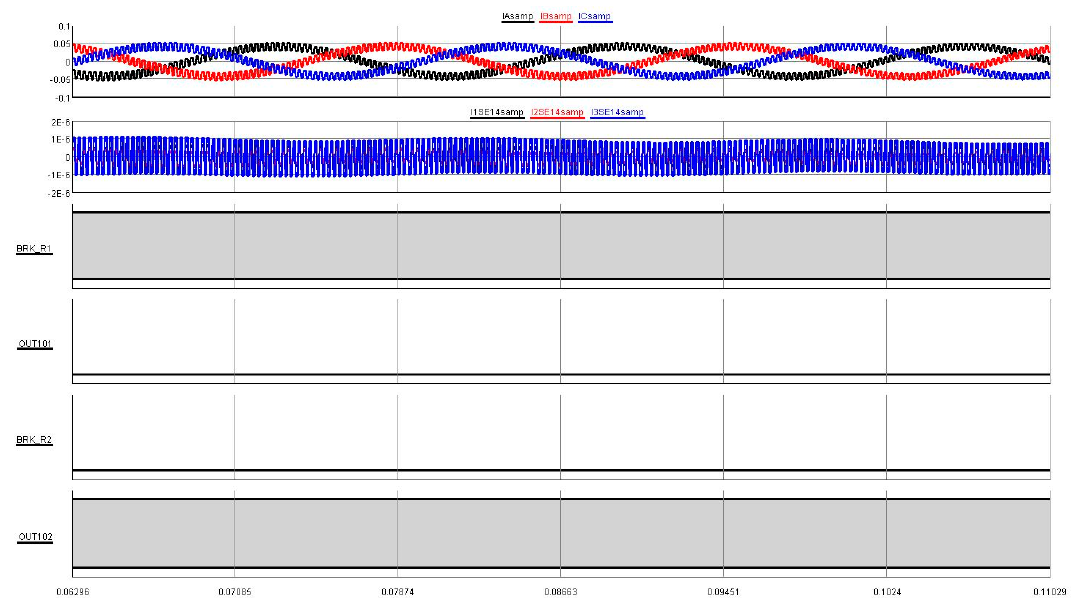
Figure 26. Waveforms for post-fault condition when R2 operates—case 1.